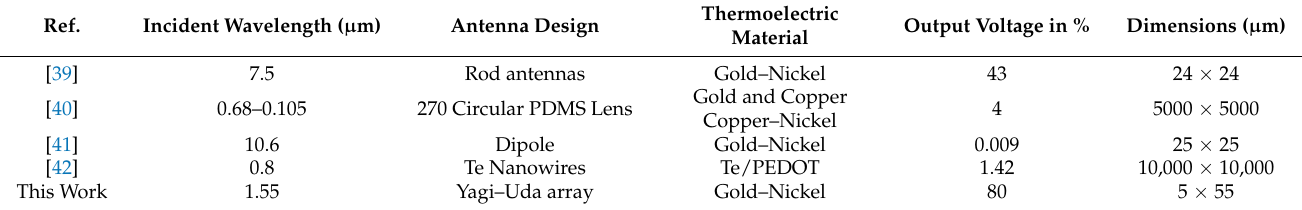
Table 3. Comparison with similar nanoantenna designs for detecting infrared energy.